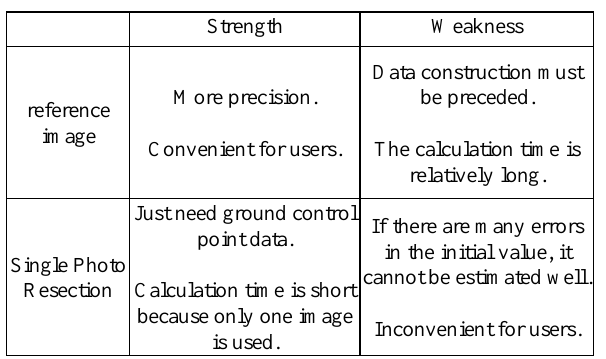
Table 1. Pros and cons of both methods